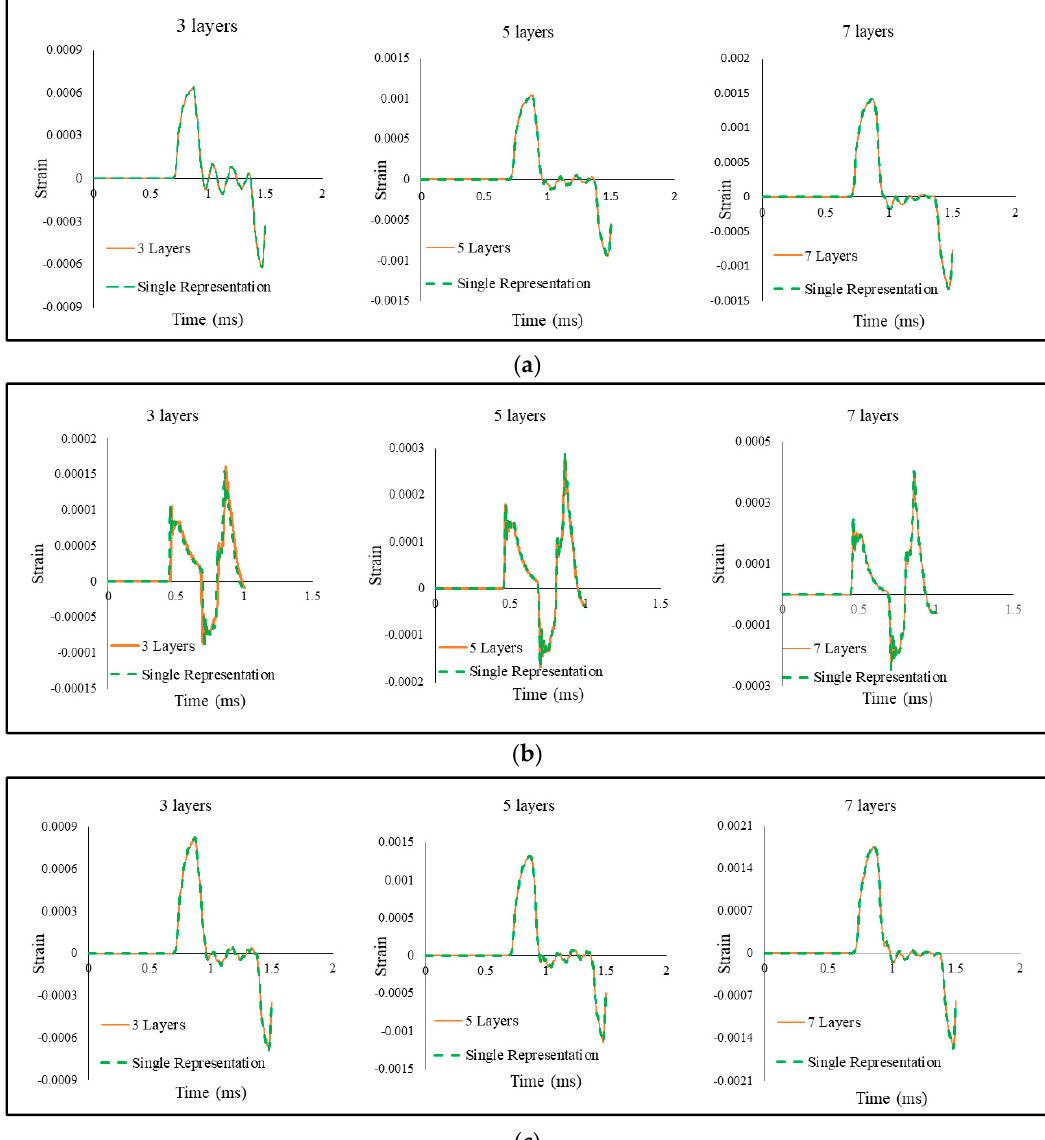
Figure 13. Comparison of strain wave generated with stacking and a single-layer specimen on ( a ) aluminum, ( b ) steel, and ( c ) copper.